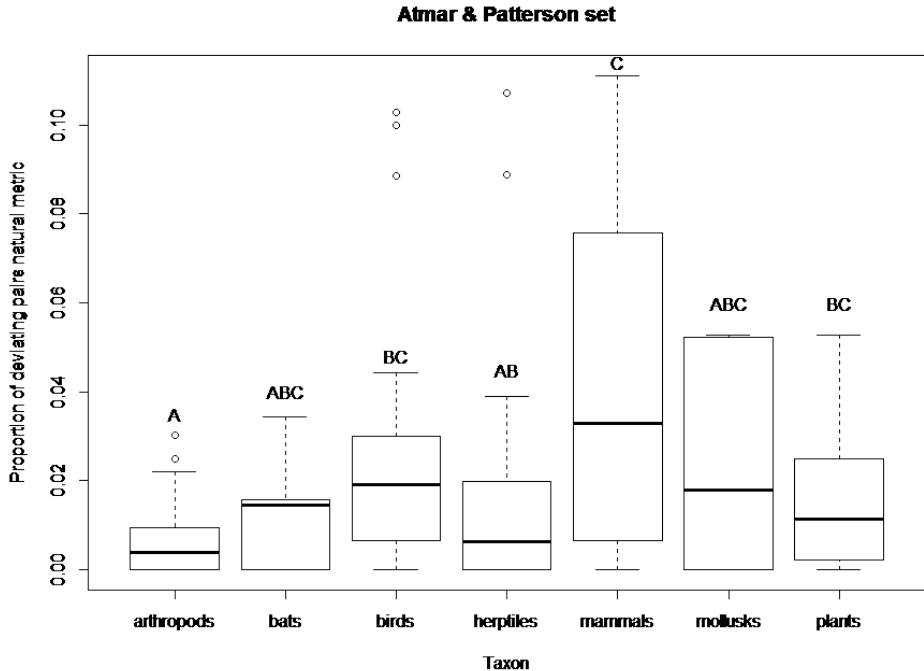
Figure 2. Boxplot showing the proportion of deviating pairs (natural metric) for each taxonomic group in the Atmar and Patterson’s [20] set of published matrices. The thick line in each box represents the median of the sample. Circles represent sample outliers. Letters above plots indicate similarities among taxa (same letters stand for no statistical